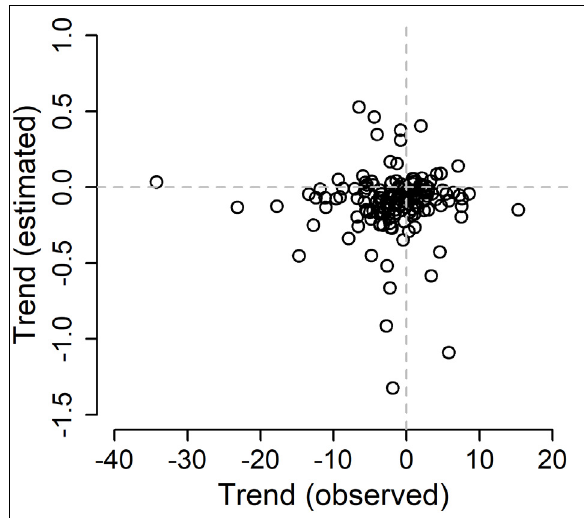
Figure 4: The slope coefficients (trend) in the regression equations of the Standardised Precipitation Evapotranspiration Index estimates plotted against the slope coefficients of the regression equations of the observed evaporation values (mm/a), n =154.